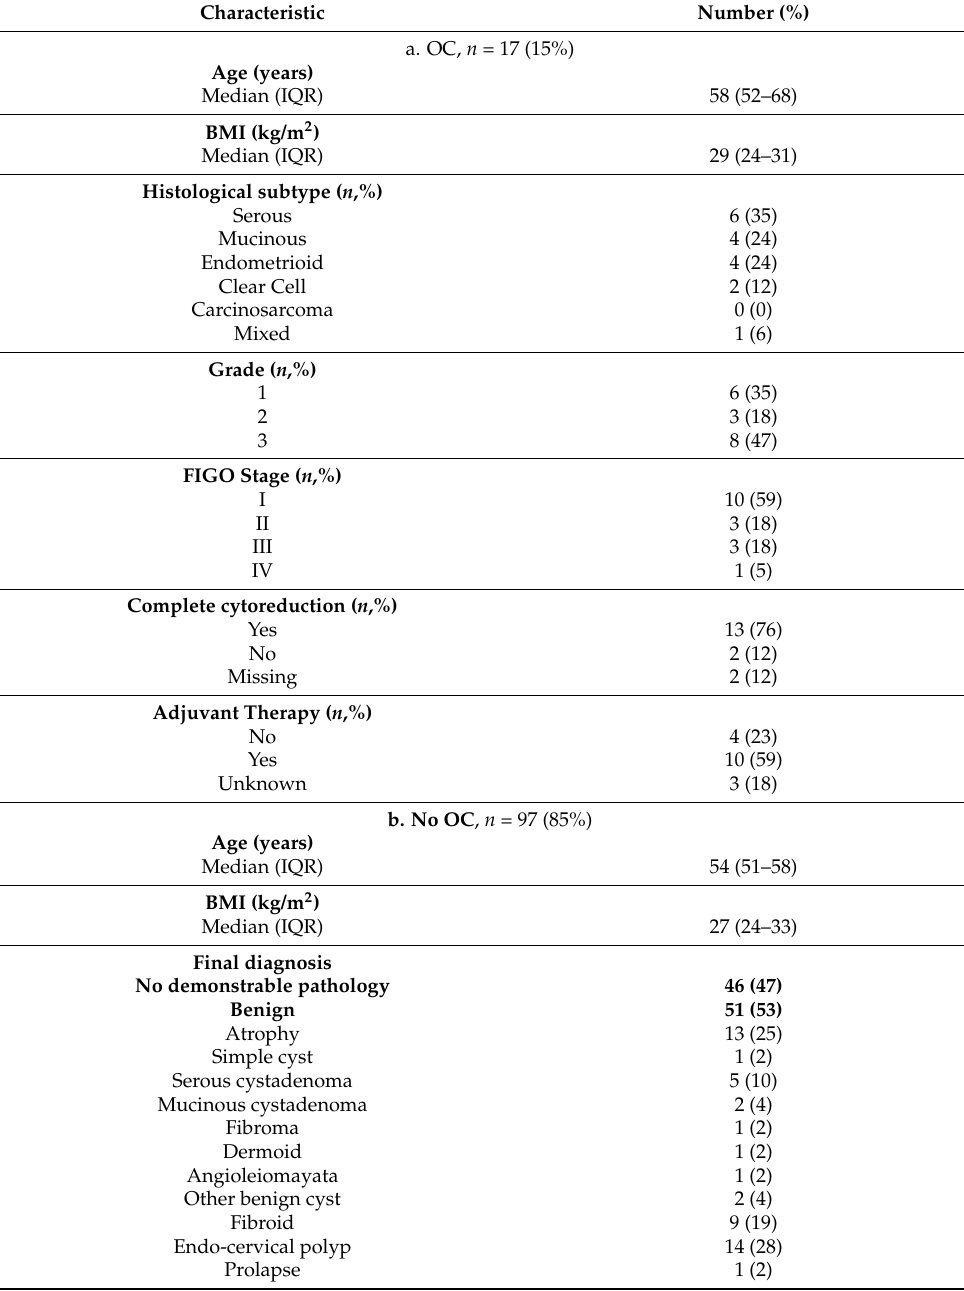
Table 1. Clinico-pathological characteristics of the